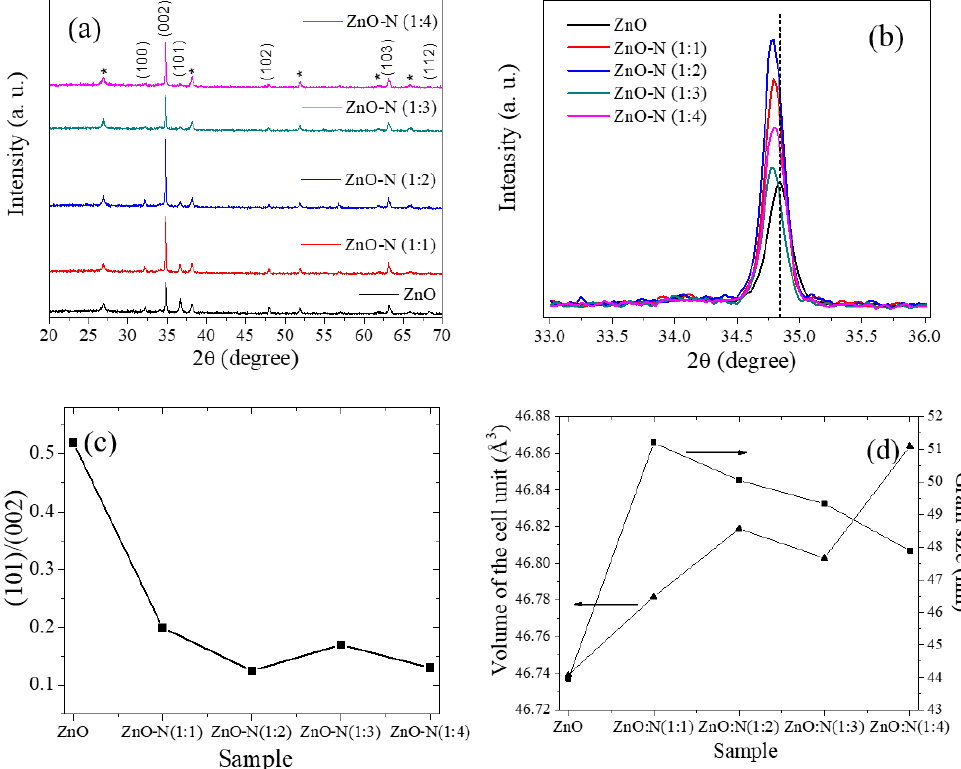
Figure 4. The ZnO and ZnO:N NRs films shown: ( a ) the diffraction patterns, ( b ) an enlarged view of the diffraction peak associated to the crystalline plane (002), ( c ) relative intensity ratio of (101)/(002) peaks, and ( d ) volume of the unit cell and grain size.